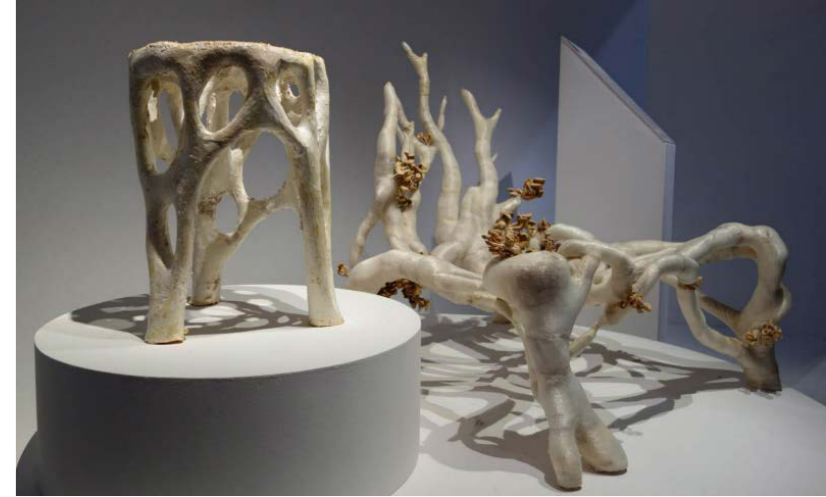
Figure 3 Eric Klarenbeek's Mycelium Studies (Url-7).